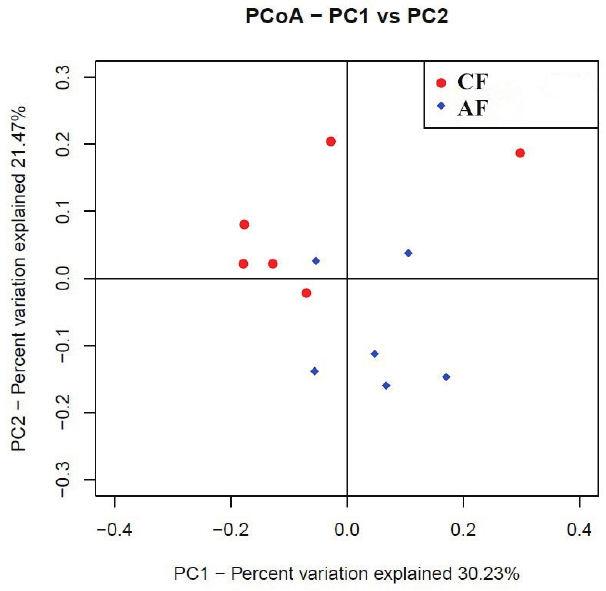
Figure 2. The principal co-ordinate analysis (PCoA) of microbial operational taxomonic units (OTUs) from goats fed a completed feed (CF) or all forage (AF)